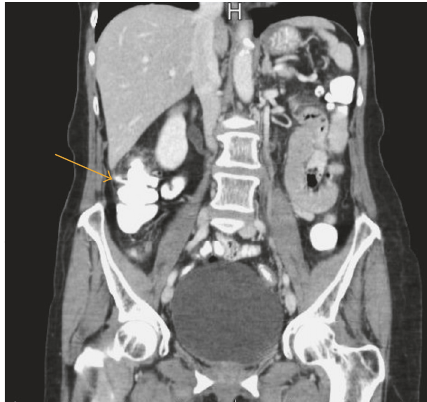
Figure 2: CT scan (coronal view) showing an extension of contrast from the right posterior colon, cranial to the